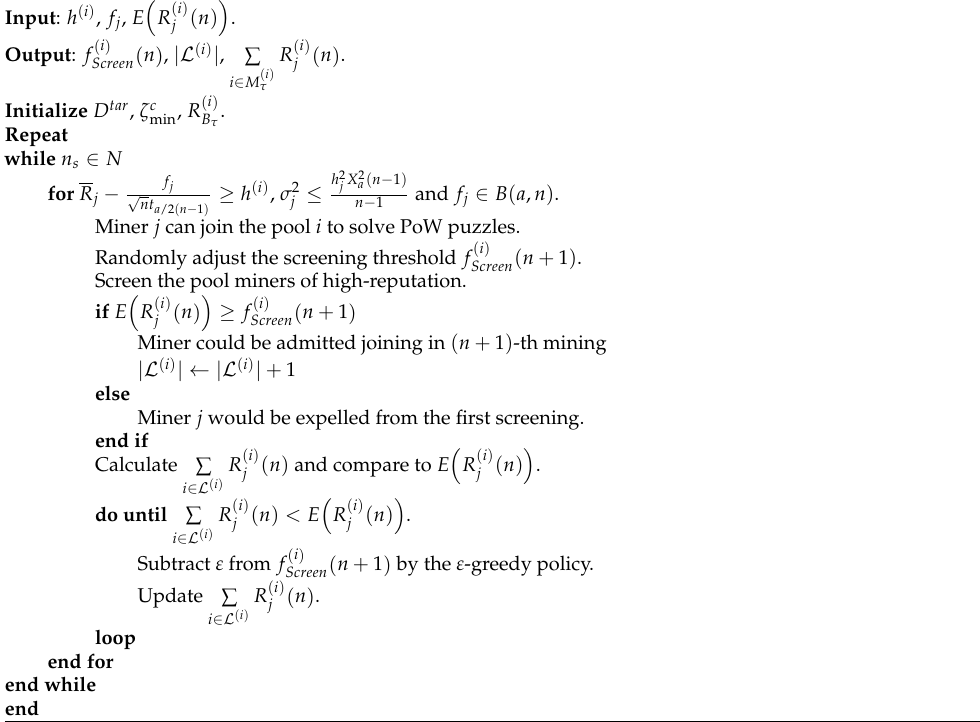
Algorithm 2 A low-reputation miner screening algorithm for mining